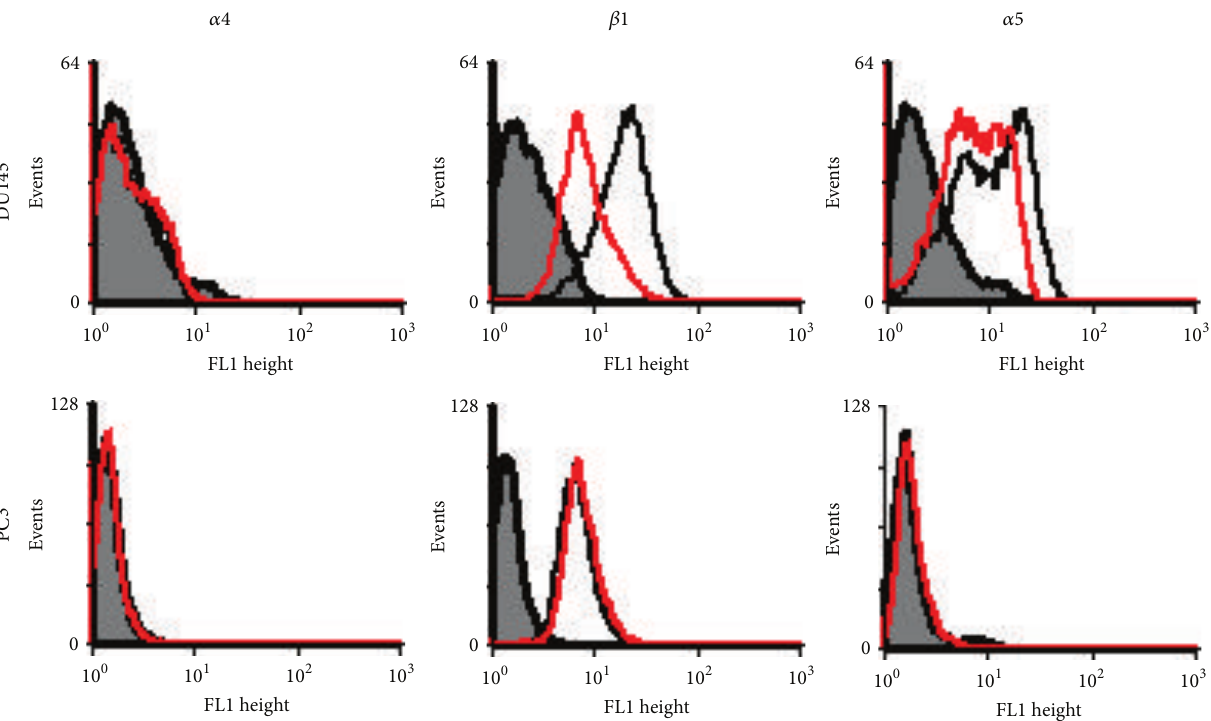
Figure 8: Flow cytograph analysis of 𝛼 4, 𝛽 1, and 𝛼 5 integrin subunits in untreated (C curve) and 200 ng/mL CXCL12 (T curve) treated cells. The T curves represent the binding of anti-integrin antibody on treated cells, the C curves represent the binding of anti- 𝛼 5 integrin antibody on untreated cells, and the mock curves (M) show the corresponding negative control